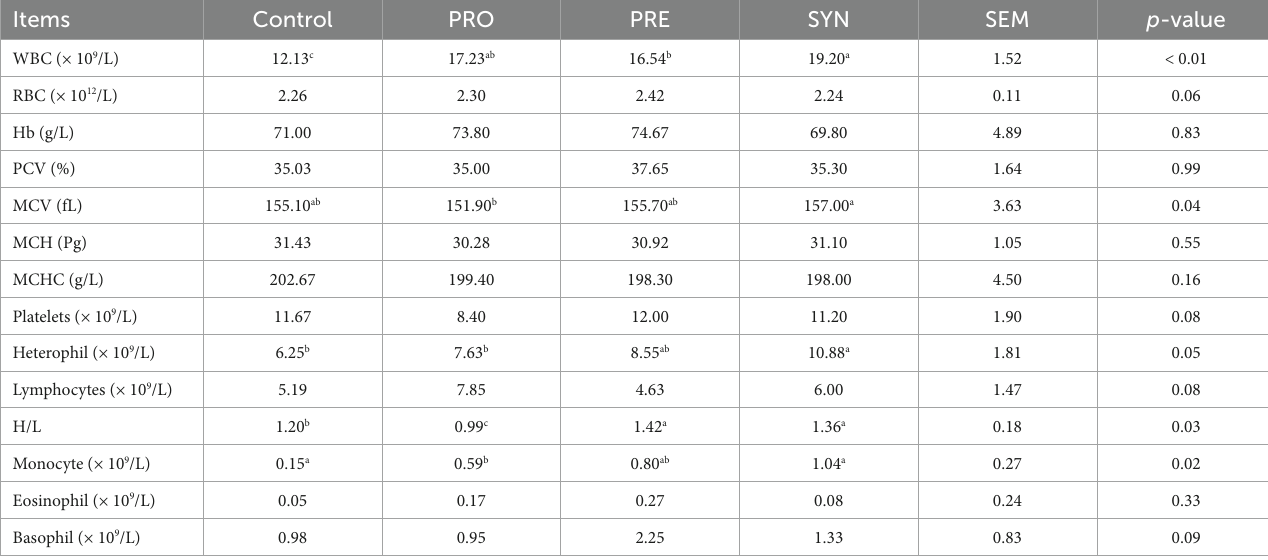
TABLE 4 Effects of dietary treatments on the Hematological indices of laying hens. Items